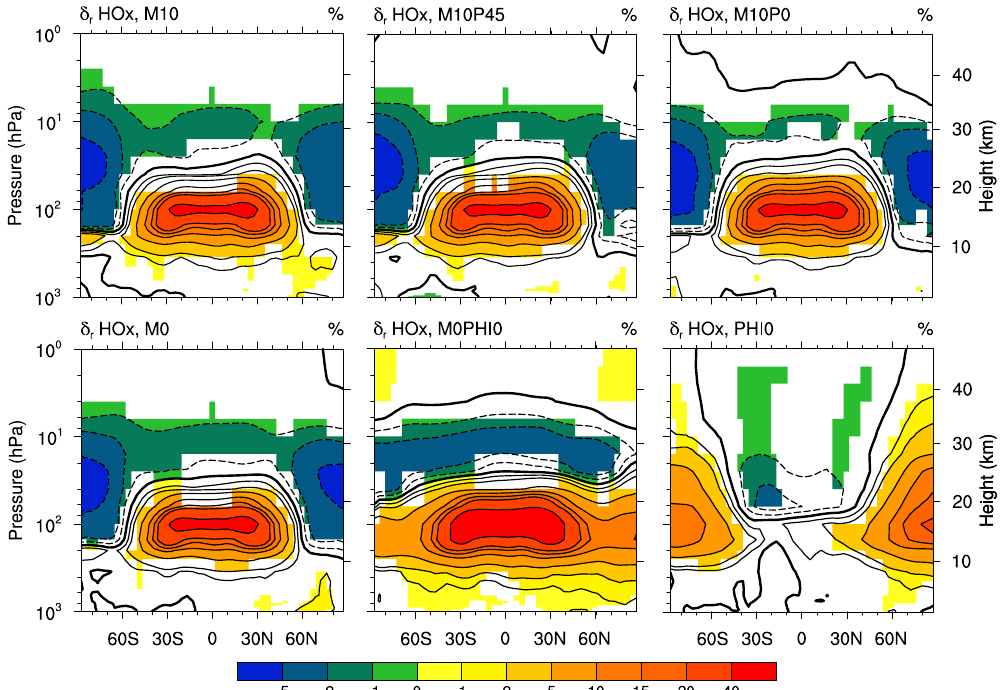
Figure 2. Simulated effects on zonally averaged mean annual HO x concentrations. Coloured areas are significant at a 5% level. Solid contours indicate positive, dashed contours negative changes.